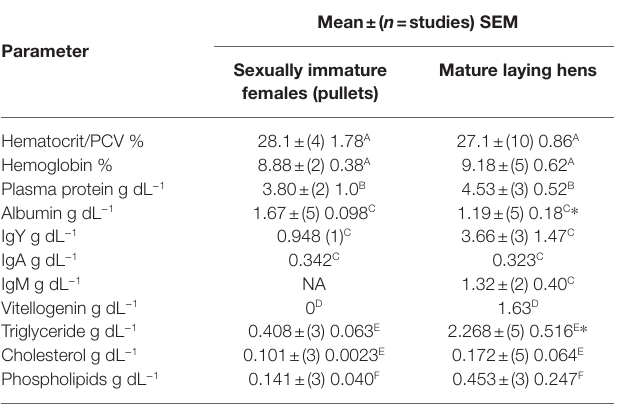
TABLE 2 | Comparison of characteristics of blood in sexually immature females (pullets) and laying chickens ( Gallus gallus ). Mean ± ( n = studies) SEM Parameter Sexually immature Mature laying females (pullets)